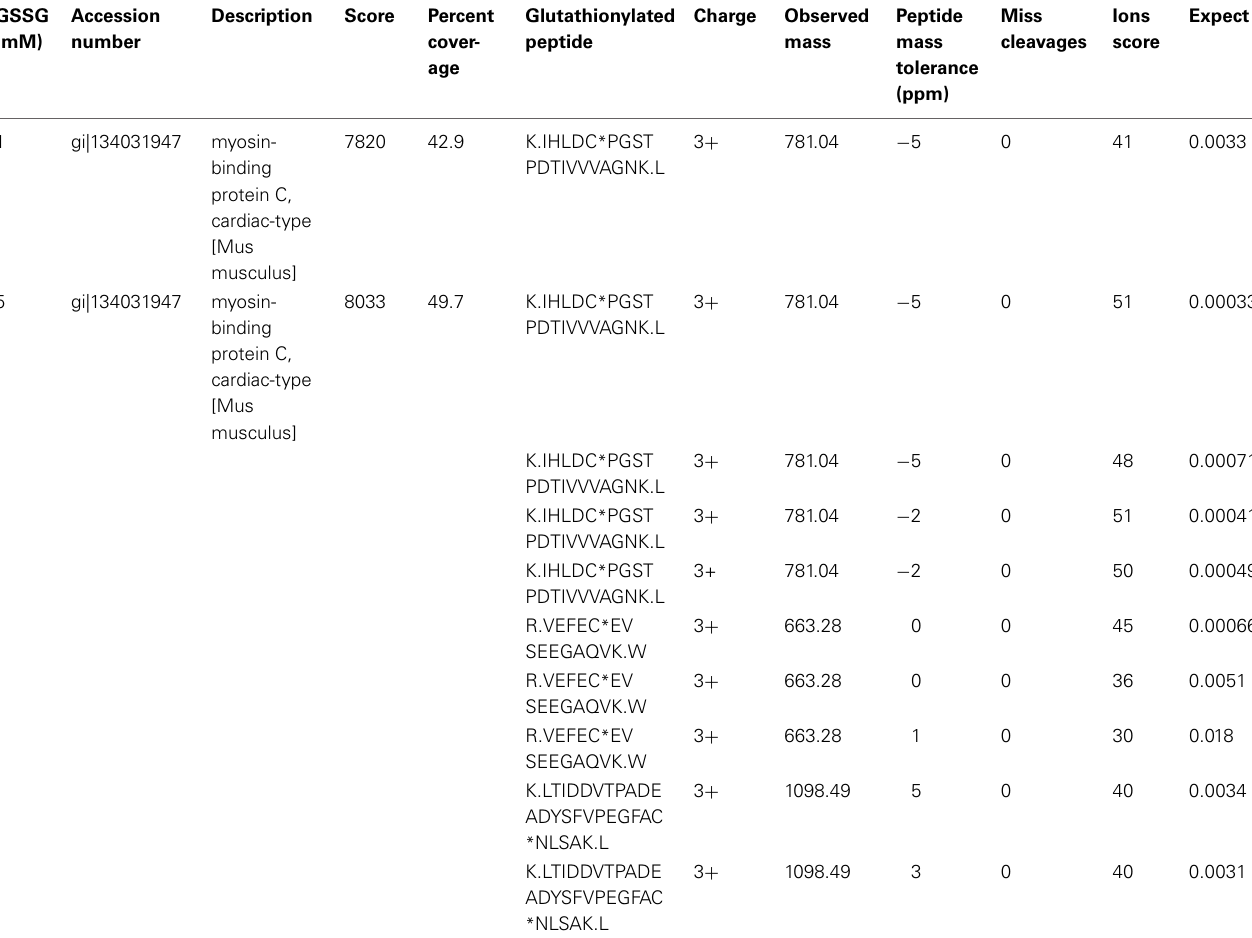
Table 1 | Significantly glutathionylated peptides discovered by mass